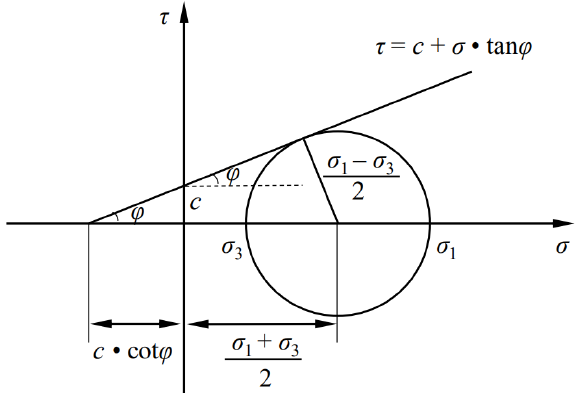
Figure 8. Schematic diagram of the Mohr–coulomb criterion. On the basis of the triaxial compression test results of RAC under different confining pressures and curing conditions, the values of c and φ are determined by linear regression. 4. The goodness of fit close to 1 indicates that c and φ of RAC under different curing con- ditions can be obtained exactly by the Mohr–Coulomb criterion.